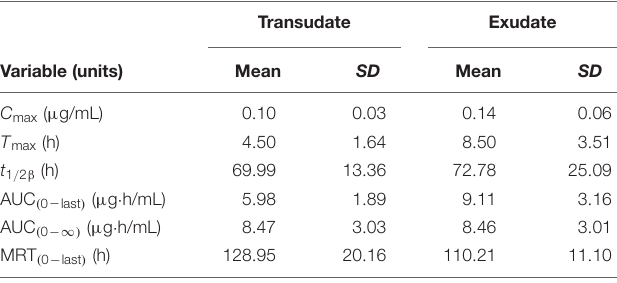
TABLE 2 | The pharmacokinetic parameters (non-compartmental analysis) of tulathromycin in exudate and transudate after i.v. administration at a dosage of 2.5 mg/kg (mean ± SD, n = 6).